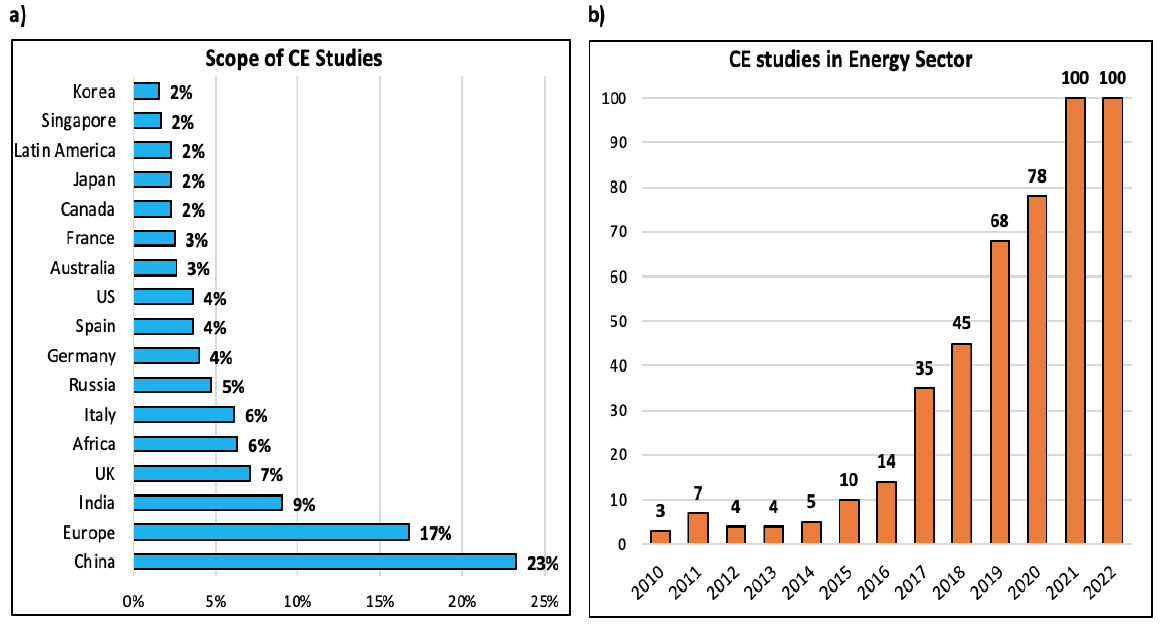
Figure 3. Main characteristics of the literature. Section “ a ” shows the share of studies based on their scope of research, while Section “ b ” shows the number of CE studies in the energy